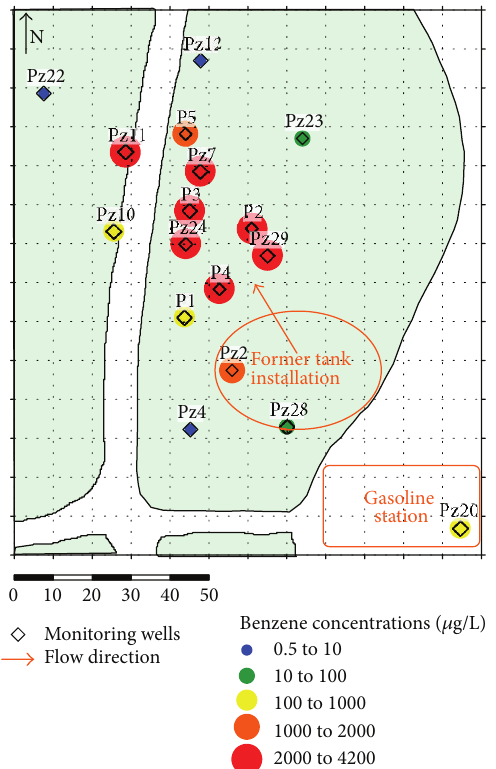
Figure 1: Map of the site showing gasoline station, former tank installation, monitoring piezometers, and the benzene concentra- tions measured in water in September 2013.